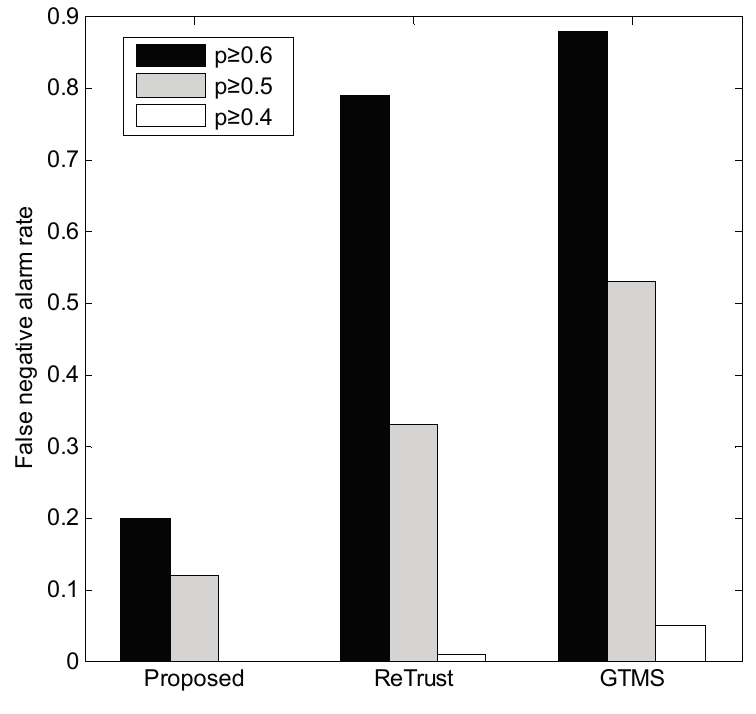
Figure 8. False-negative alarm rate.